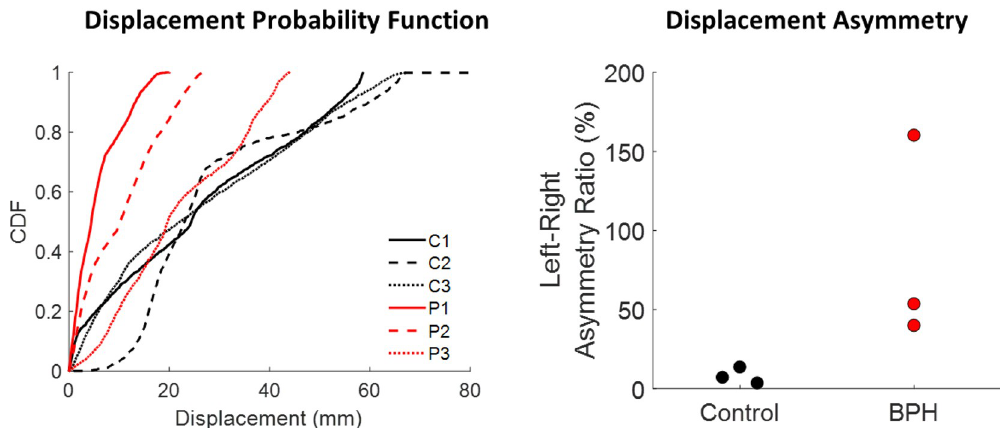
Fig 5. Probability density functions of bladder wall displacement show the control subjects bladder move much more during voiding. Additionally, the men with BPH/LUTS exhibit significant left-right asymmetry that was not observed in the control